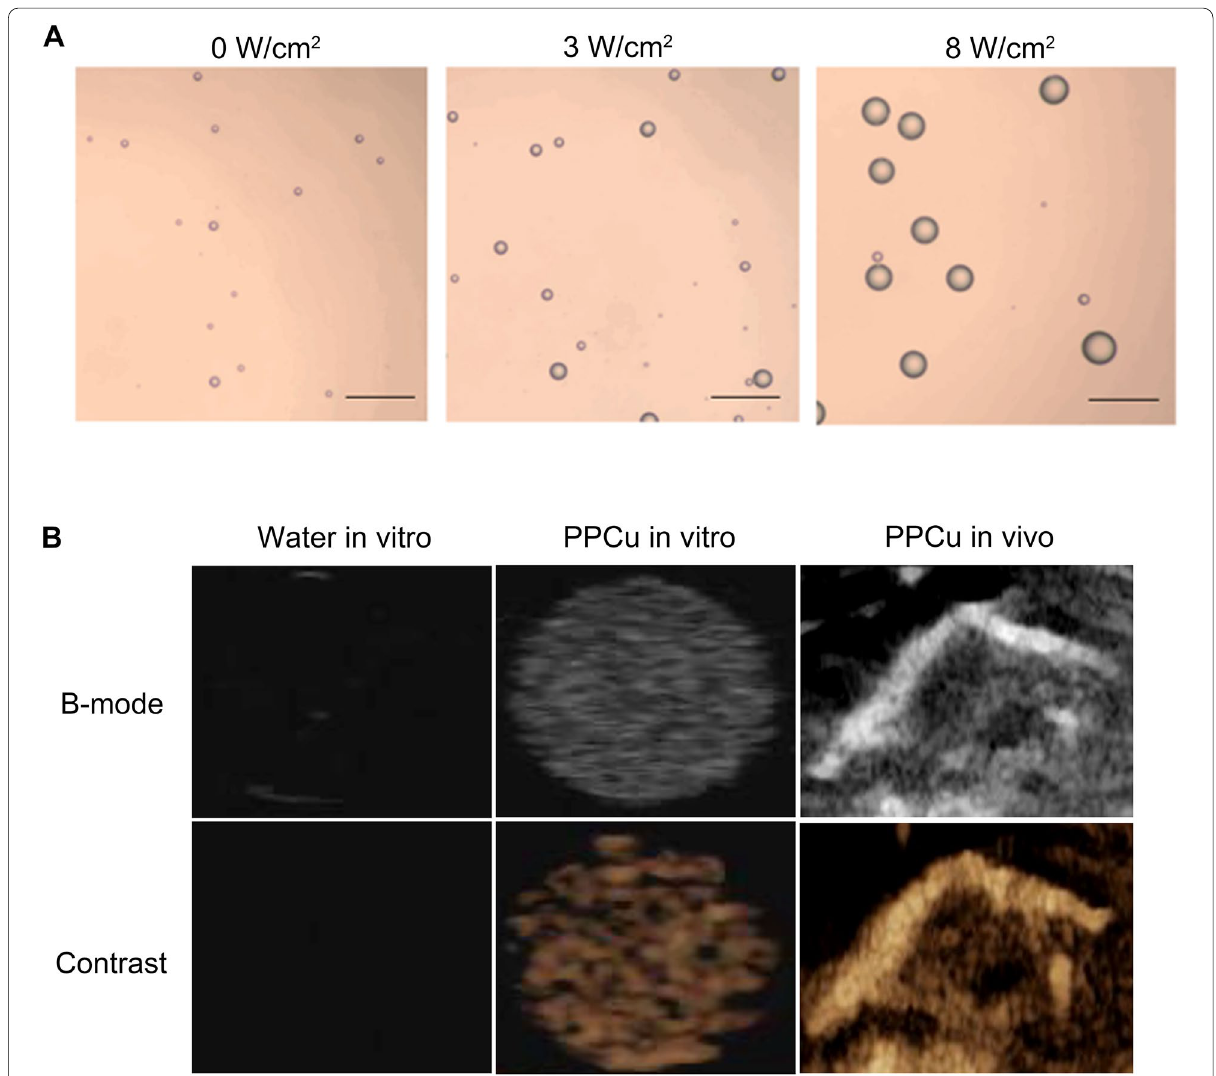
Fig. 2 Acoustic droplet vaporization and CEUS of PPCu. A Optical microscopic images of PPCu after LIFU treatment with different intensities (0 W/ cm 2 , 3 W/cm 2 and 8 W/cm 2 for 3 min). The scale bar is 5 μm. B B-mode and CEUS mode images of degassed water and PPCu in vitro and in vivo after LIFU